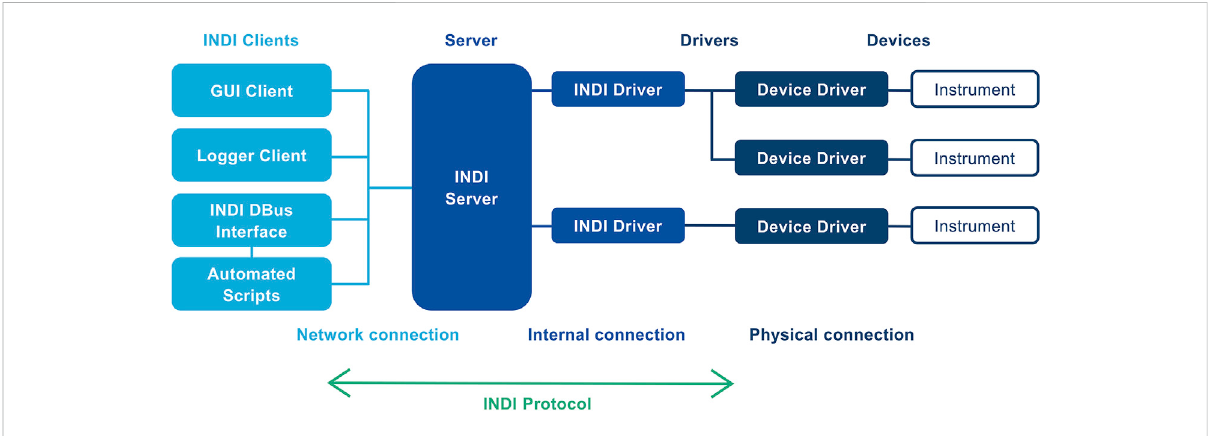
FIGURE 2 Schematic representation of the operation principle of INDI from typical clients to the different telescope instruments with the INDI Server and Drivers controlled by the INDI Protocol and their connection